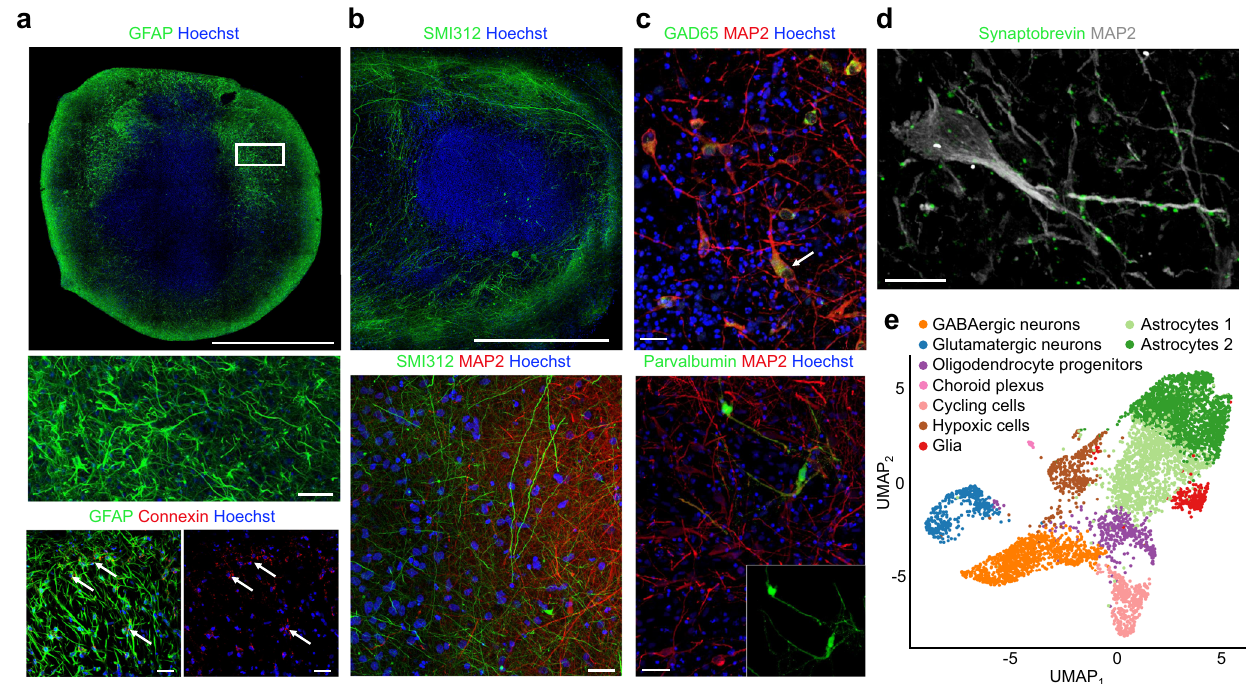
Fig. 2 | Human brain organoids form a scaffolding capable of supporting neuronal microcircuitry. a Top, high-resolution, whole-section of an 8-month organoidimmunostainedwithanti-GFAP(green),andcounterstainedwithHoechst (cellnuclei,blue),scalebar1mm.Middle,ahighmagni fi cationof(topbox)showing stellate appearance characteristic of astrocytes. Bottom left, Anti-GFAP-positive astrocytes (green) in an 8-month organoid co-labeled with anti-connexin 43 demonstrating gap junctions (red). Bottom right, connexin 43 gap junction (red; arrows). Middle and bottom scale bars are 40 µ m. b Top, long neuronal processes labeledwithanti-SMI312(green)inan8-monthorganoid,scalebar500 µ m.Bottom, anti-SMI312 (green) axons neighboring MAP2-positive (red) neurons near the